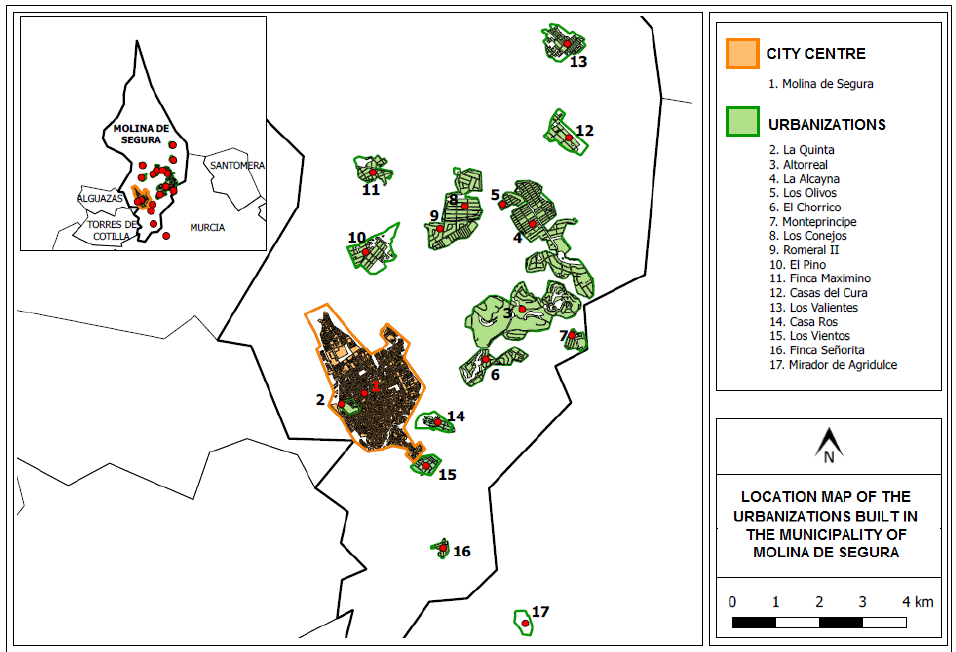
Figure 2. Location map of the urbanizations built in the municipality of Molina de Segura.